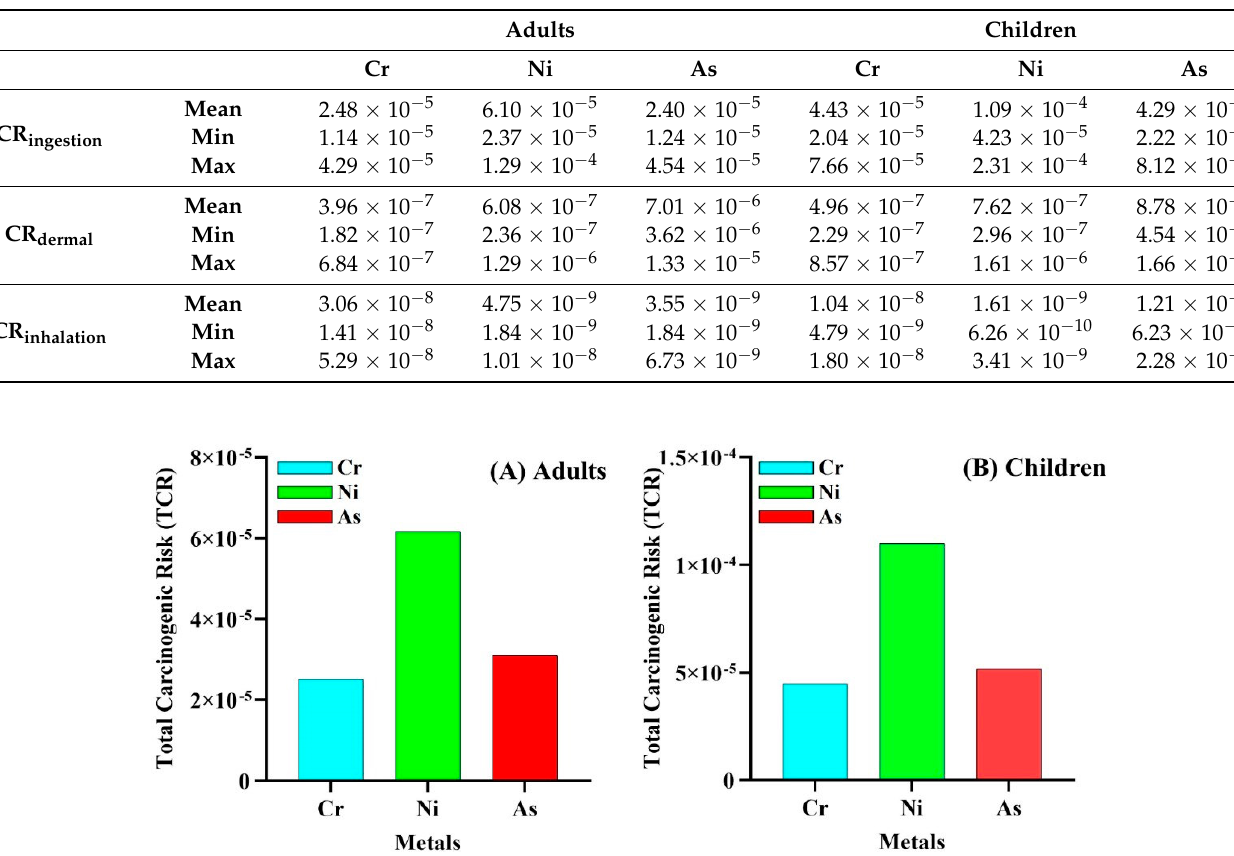
Table 3. The metals carcinogenic risk for adults and children posed by As, Cr, and Ni according to the three exposure pathways.